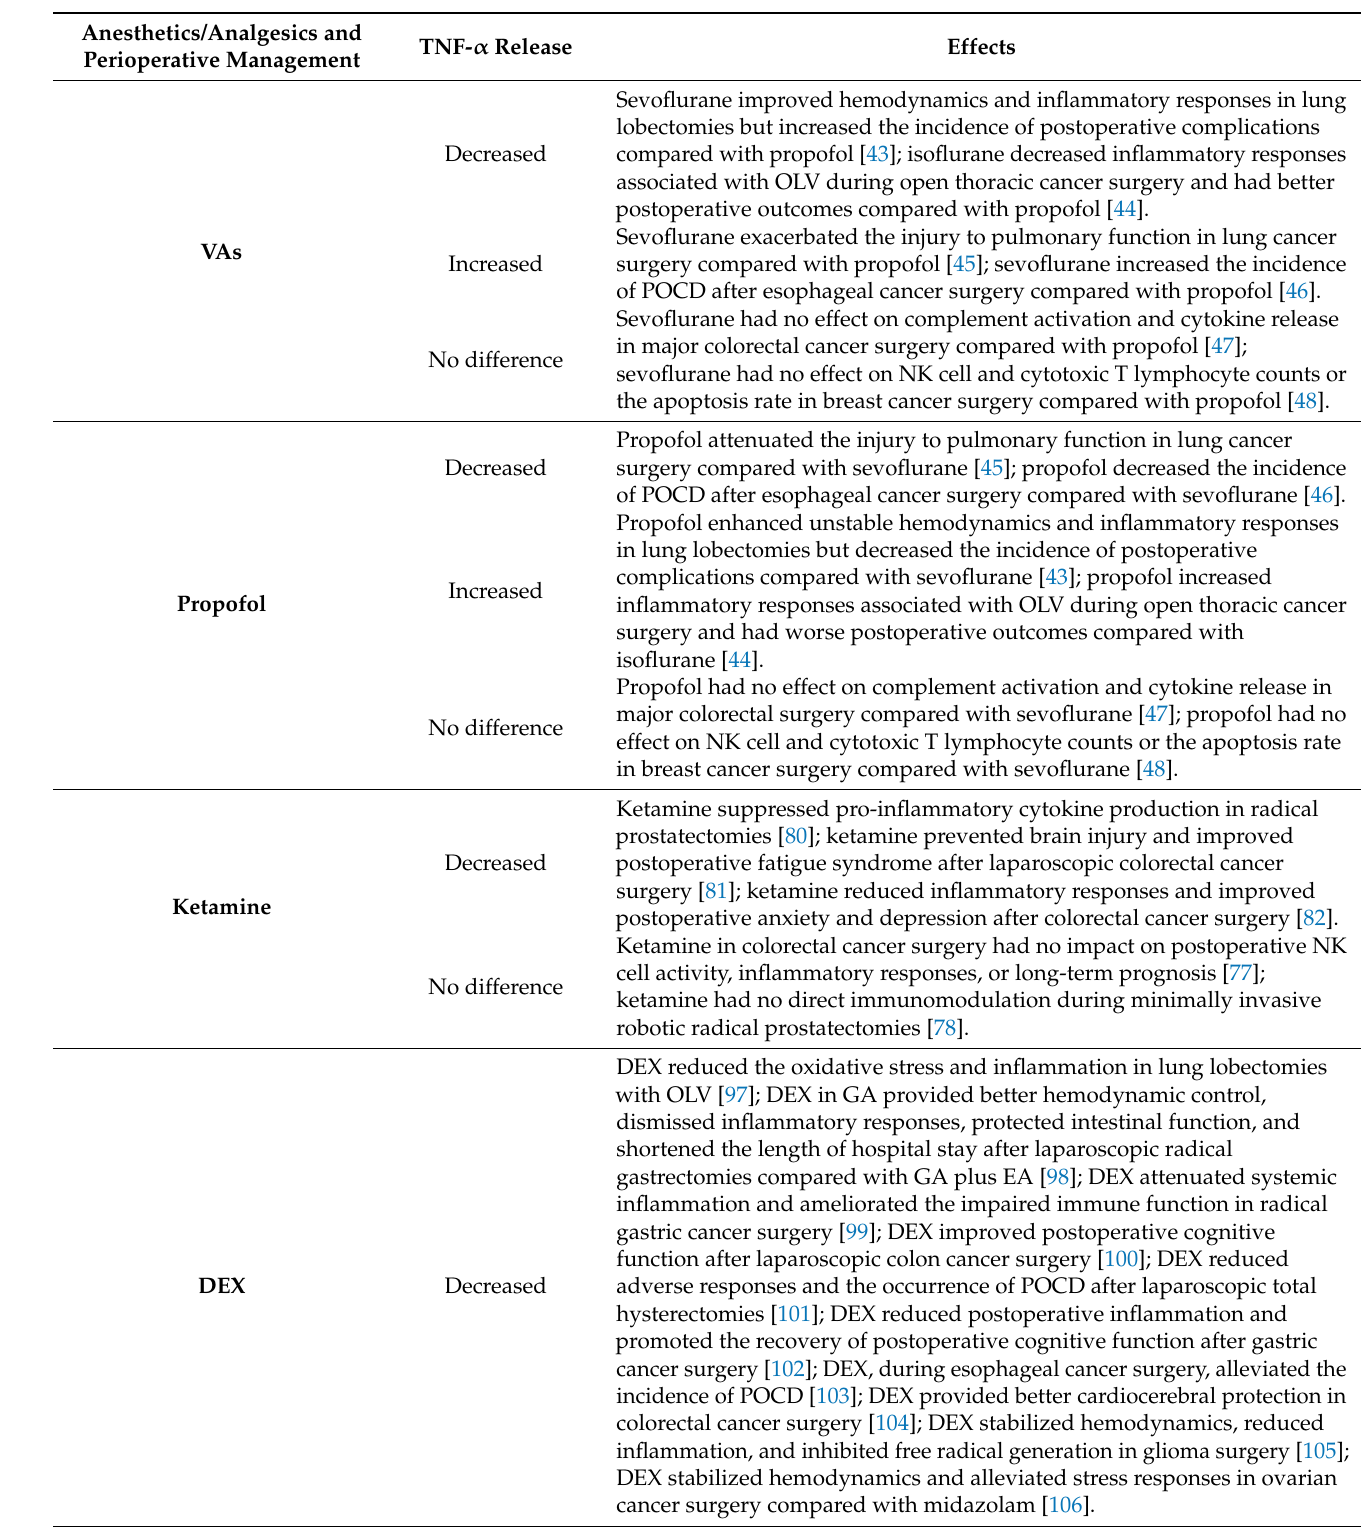
Table 2. Clinical studies on the effects of anesthetics/analgesics and perioperative care on TNF- α release and clinical